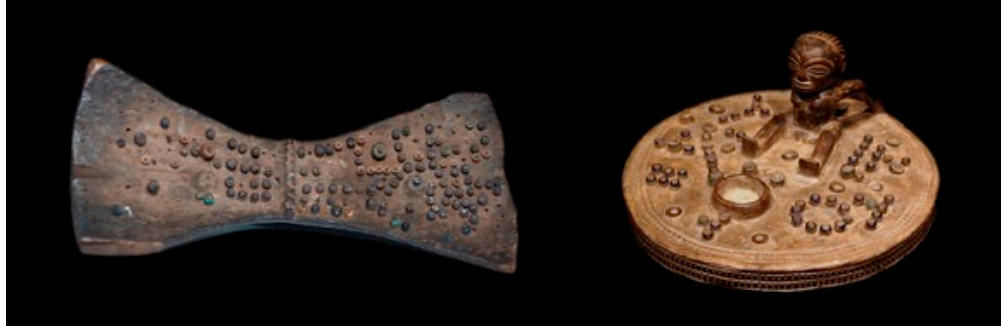
Figure 4. Lukasa board loaned by the Royal Museum for Central Africa (Tervuren, Belgium) for the Mapping Place exhibition ( left ) and by Brygg Ullmer ( right ).